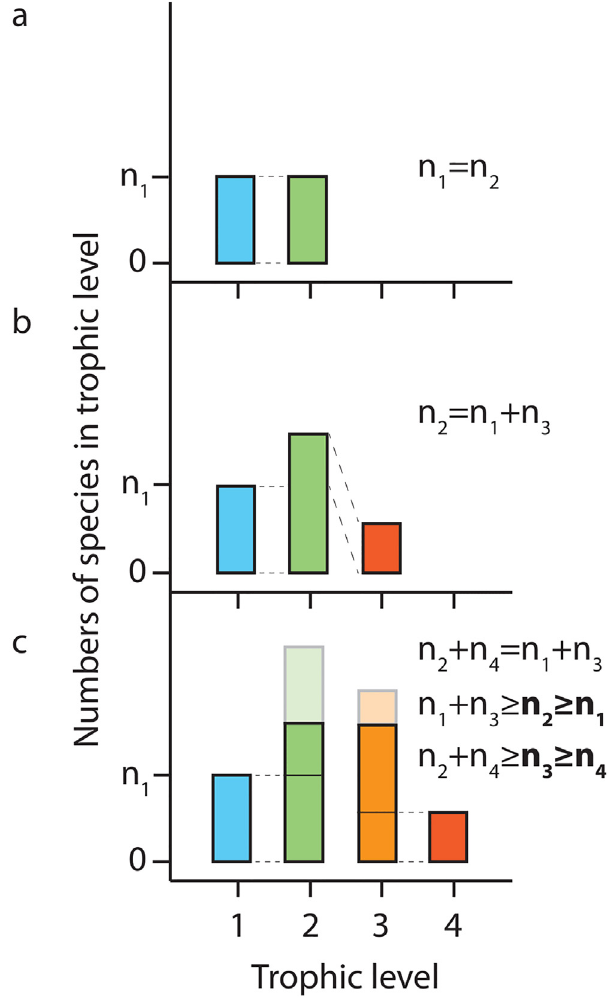
Fig 2. Species richness for different trophic levels. a , Food web with two trophic levels only; a staircase of coexistence with balanced species richness at levels 1 and 2 [18]. b , Three trophic levels. The number of intermediate species must equal the total number of basal and predator species. Intermediate species dominate ecosystem biodiversity. c , Four trophic levels. n 2 ( n 3 ) must at least match basal (predator) species richness n 1 ( n 4 ), indicated by thin black lines in green and orange bar. Solid green (orange) bars show the minimal upper bound to species richness in trophic level one (two). Species richness n 2 and n 3 can increase even further by co-evolution of intermediate species (shaded region). Note the applicable assembly rules shown for the different cases.